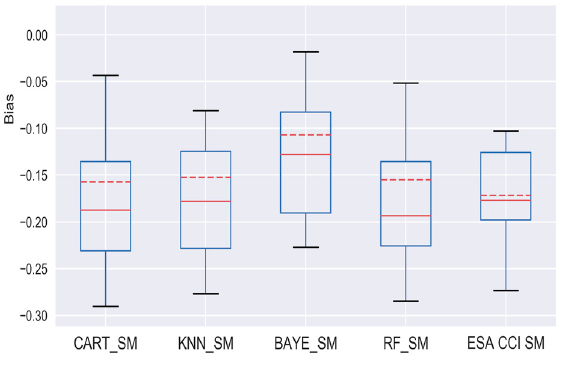
Figure 9. Box plot of Bias.